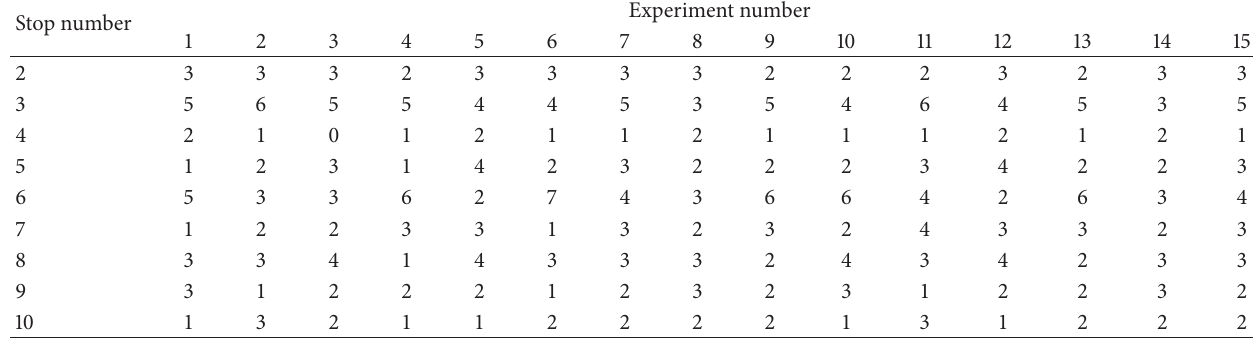
Table 6: Information on the number of outgoing